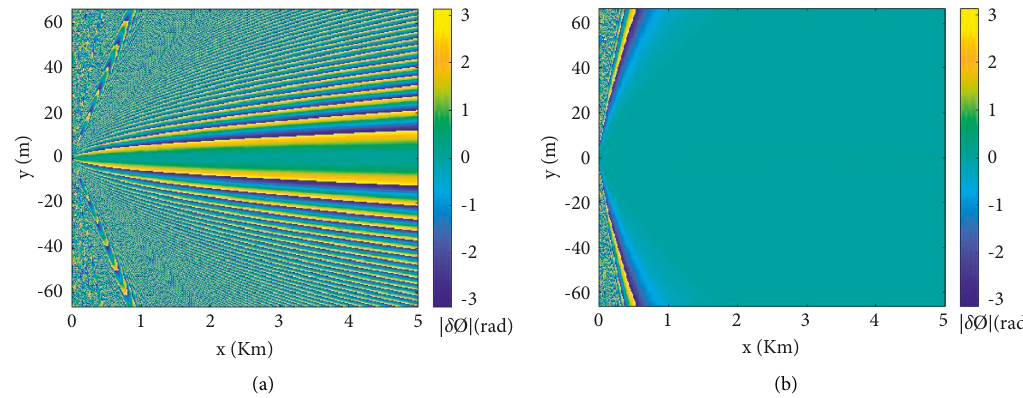
Figure 1: Comparisons on phase approximations. (a) Zeroth-order approximation. (b) First-order